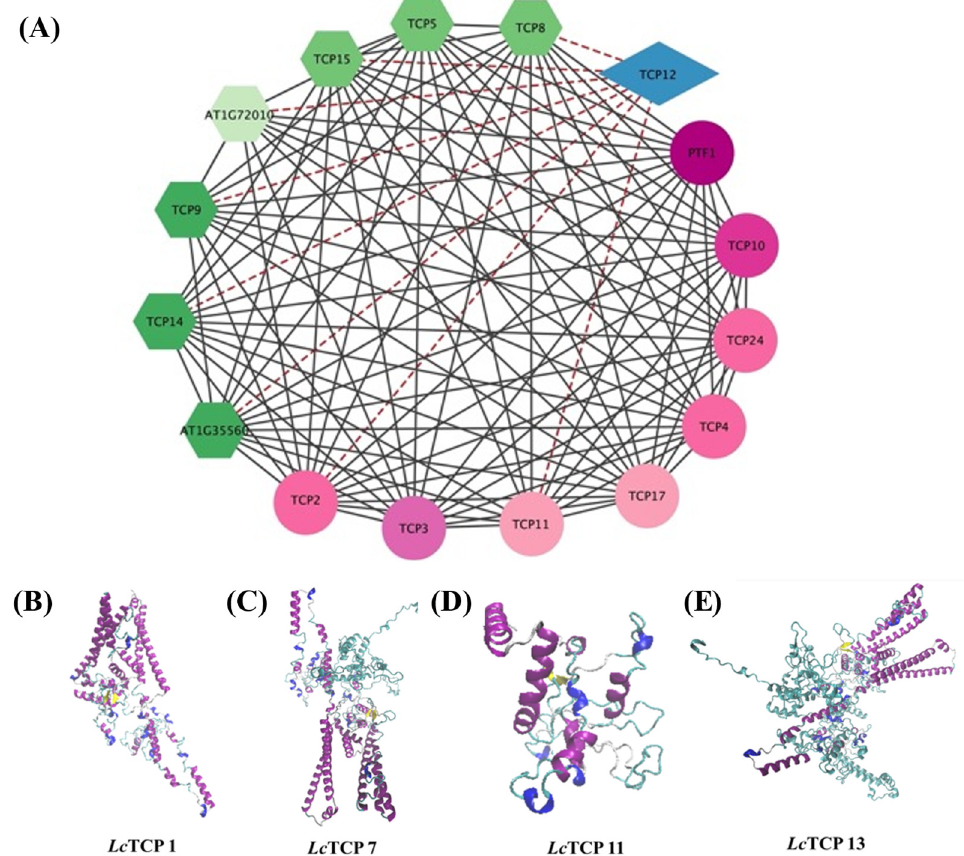
Figure 6. Protein interaction and structure analysis. ( A ) Protein-protein interaction network for Lc TCPs was analyzed by the STRING website (http://string-db.org) using the full-length protein sequences. Different color shapes represent different proteins, differentiated by varying color schemes: green for class II TCPs, pink for class I TCPs, and blue for the CYC/TB1 subclade. Below, the 3D-Protein structure prediction of ( B ), Lc TCP1, ( C ), Lc TCP7, ( D ), Lc TCP11, and ( E ), Lc TCP13, showing the potential strands, helices, and coil formation.